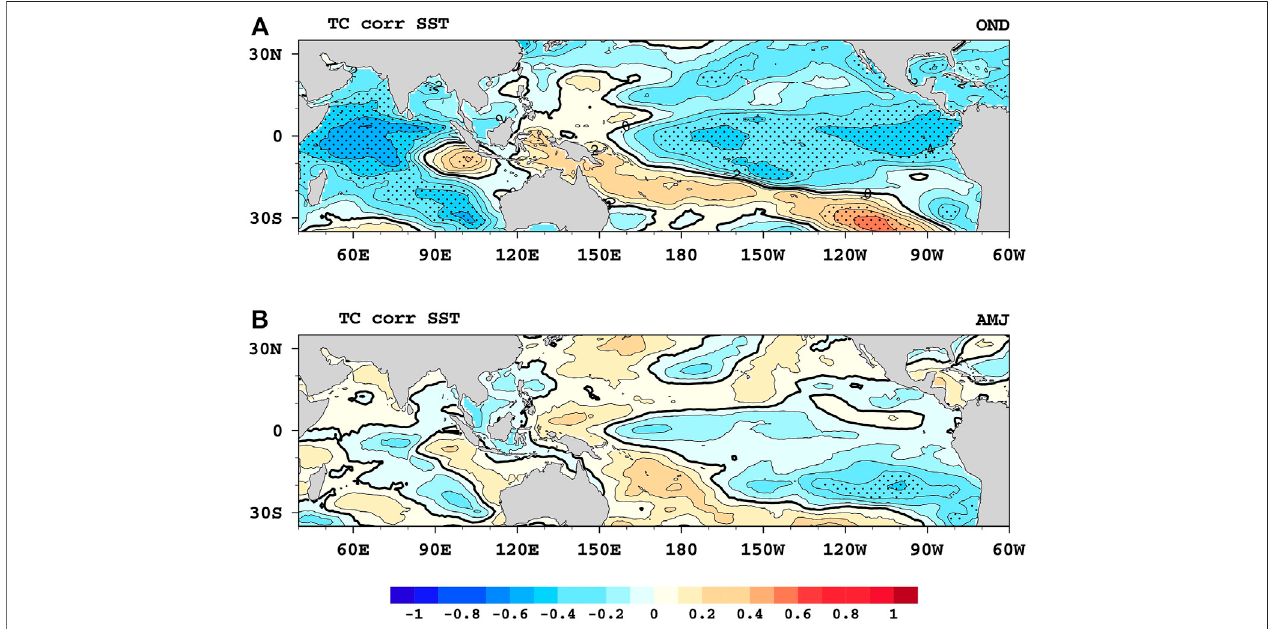
FIGURE 3 | Correlation of TC frequency and sea surface temperature (SST) OND during (A) and AMJ (B) ; Stipplings indicate that correlations are signi fi cant at the 95% con fi dence level.